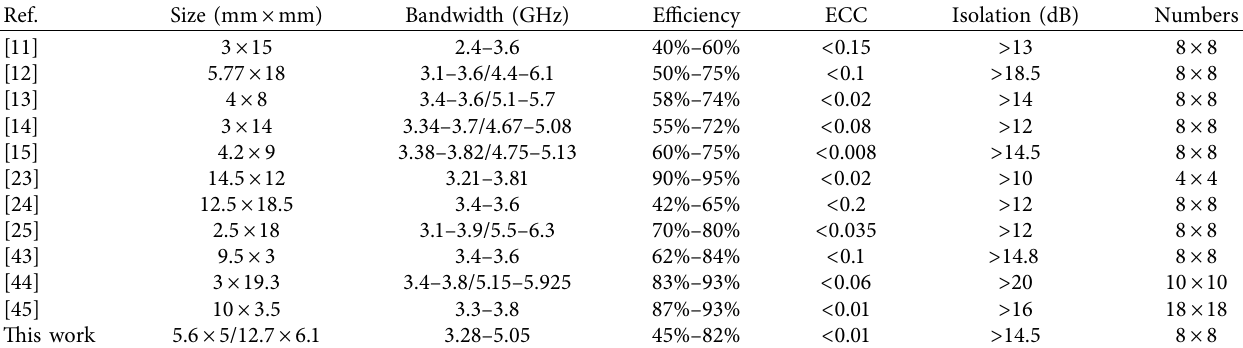
Table 1: Comparison of the proposed antennas with other works for 5G smartphones.